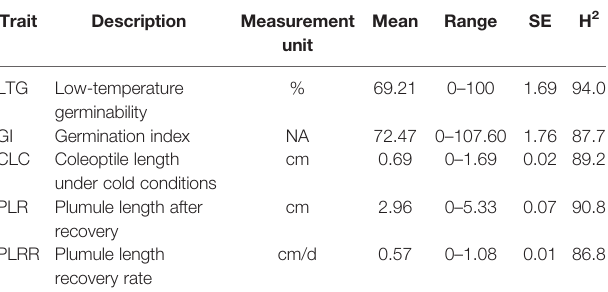
TABLE 1 | Descriptive statistics of each trait measured in the whole diversity